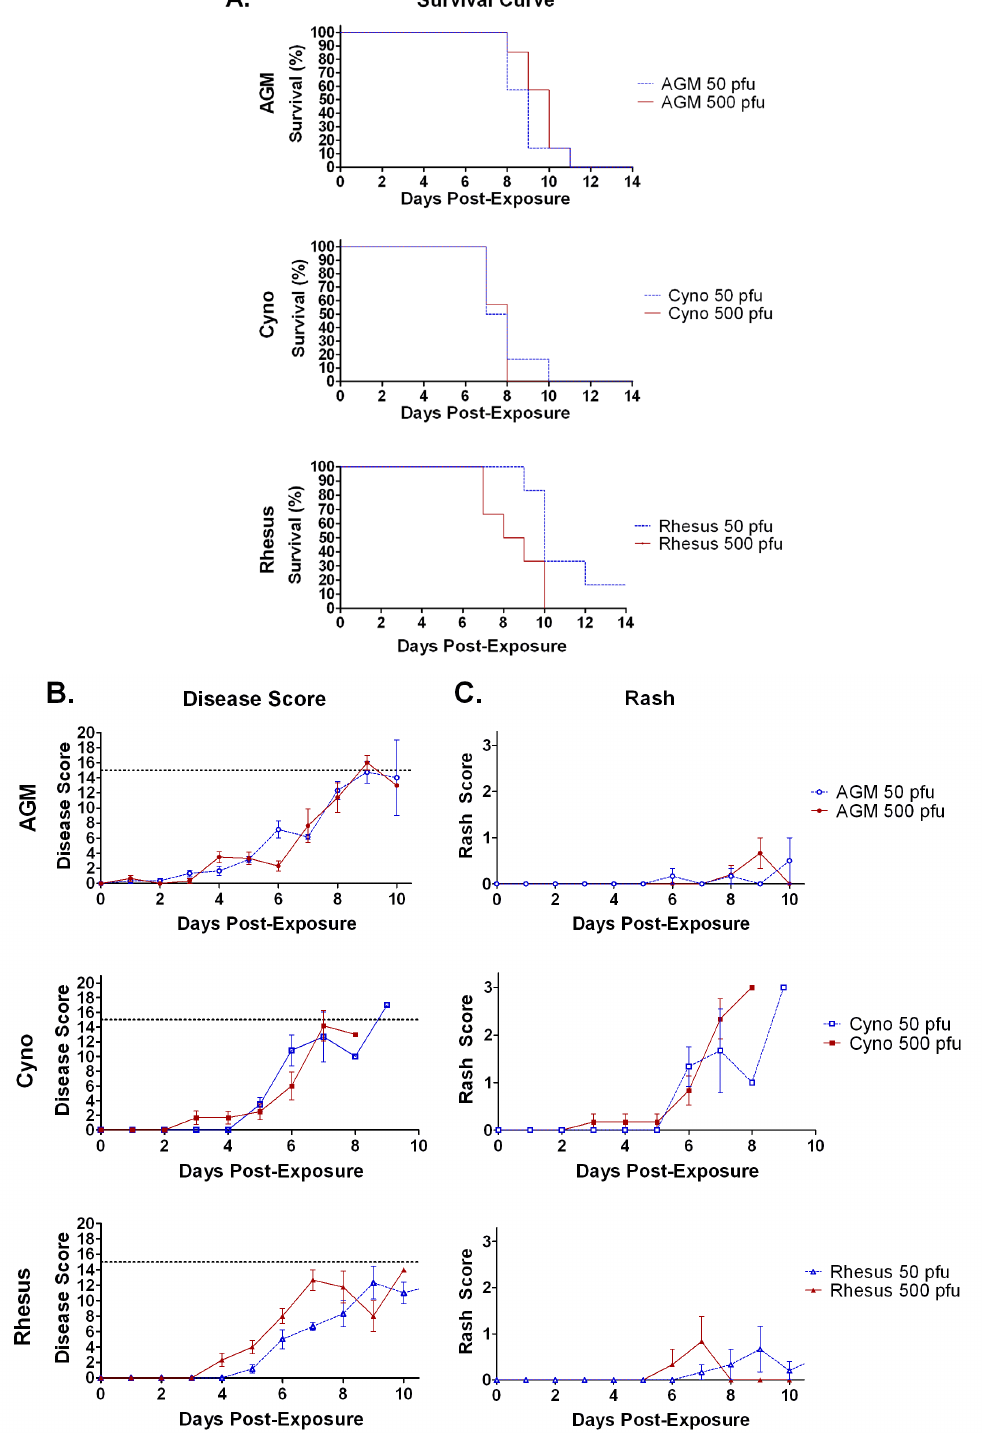
Figure 1. Survival, clinical disease scores, and rash in NHPs exposed to aerosolized SUDV. A ) Percent survival of NHP exposed via two different doses of aerosolized SUDV. B ) Average clinical disease scores and C ) average rash score over time after exposure of three different species of NHP to aerosolized SUDV (Figures B and C share a legend). There were six animals per group. Error bars represent the standard error of the mean. The dashed line on figure B represents the cutoff score, above which, animals were humanely